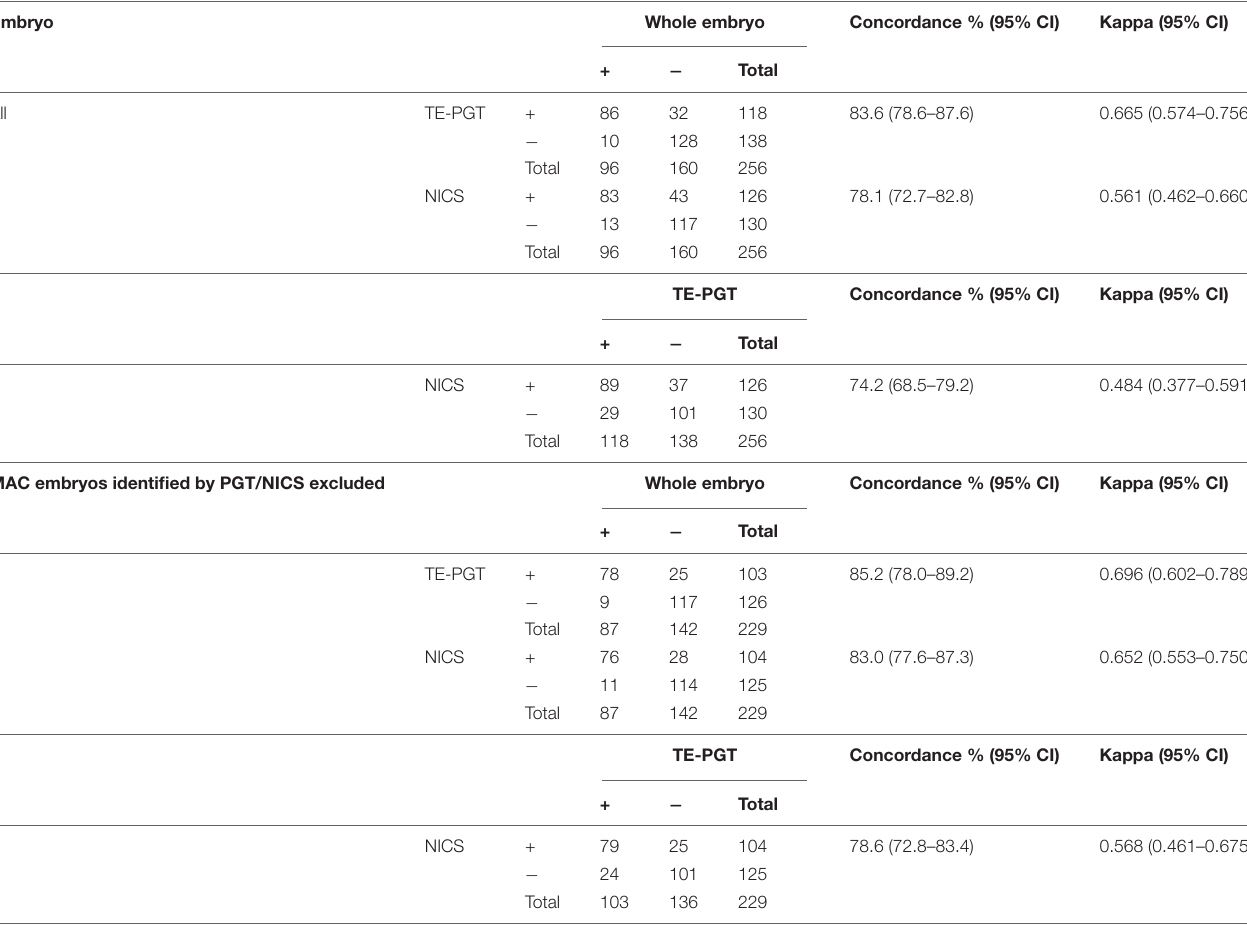
TABLE 3 | The Kappa concordance analysis between different assays. Embryo